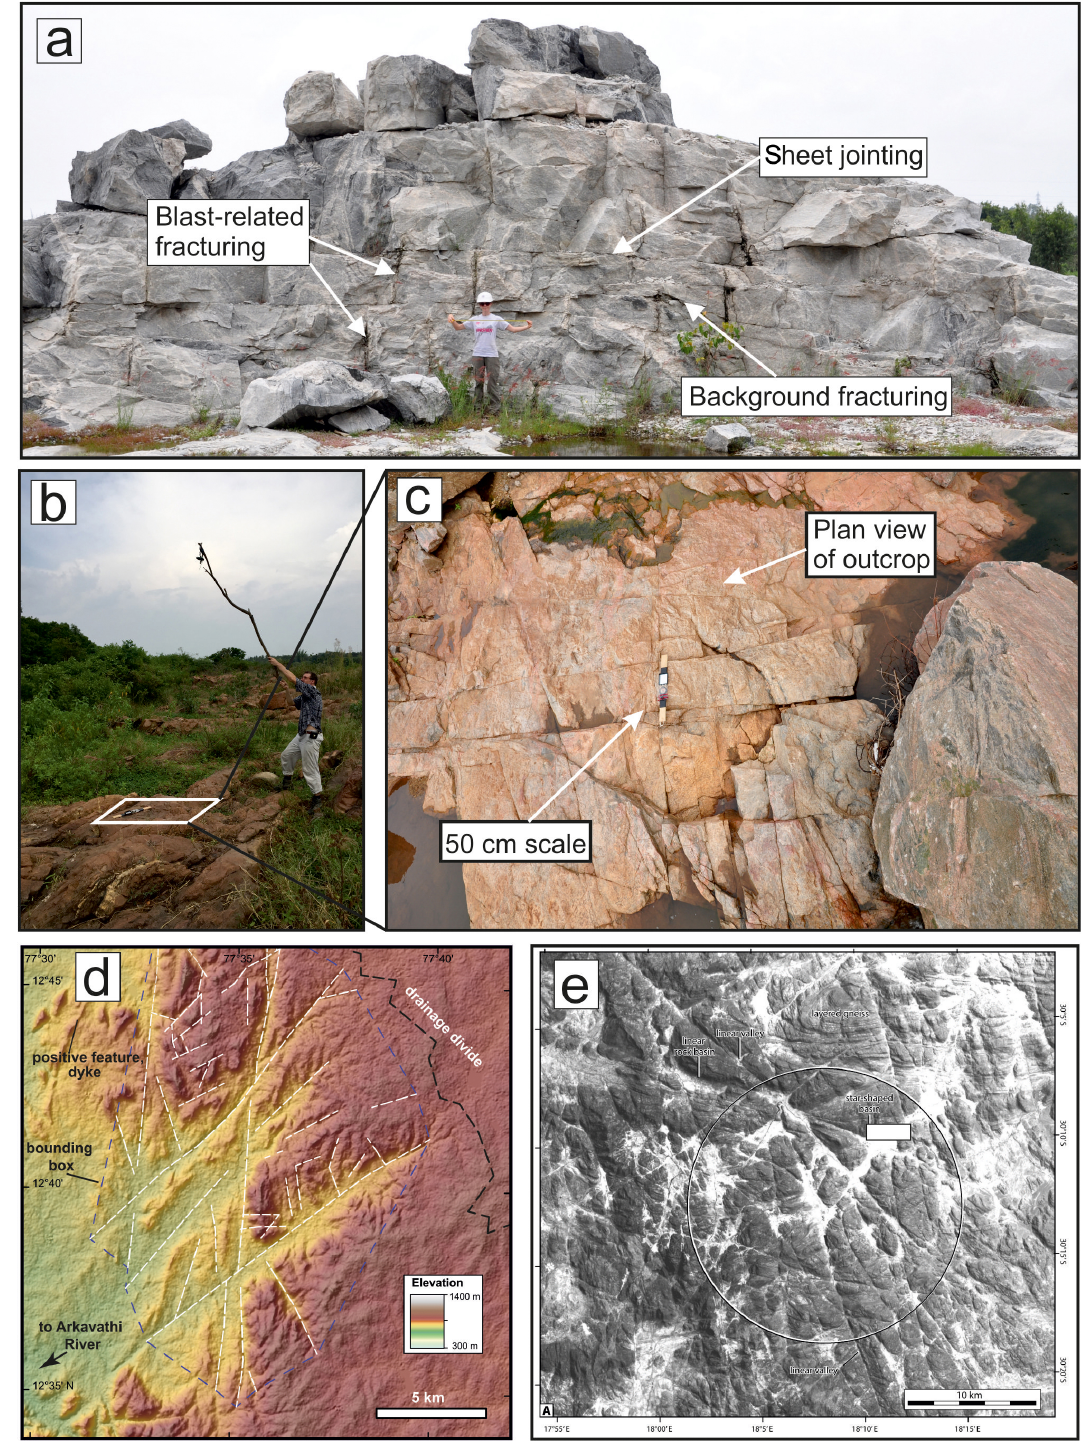
Figure 2. Examples of photographs and digital elevation model (DEM) images that can be used for digitizing 2-D linear features, including (a–c) photographs of fracture networks of various scales from southern India and improvised methods for taking photographs parallel to the outcrop, (d) a DEM image from southern India of larger kilometre-scale features that could also be digitized, and (e) an aerial photograph from Namibia (adapted from Krabbendam and Bradwell,